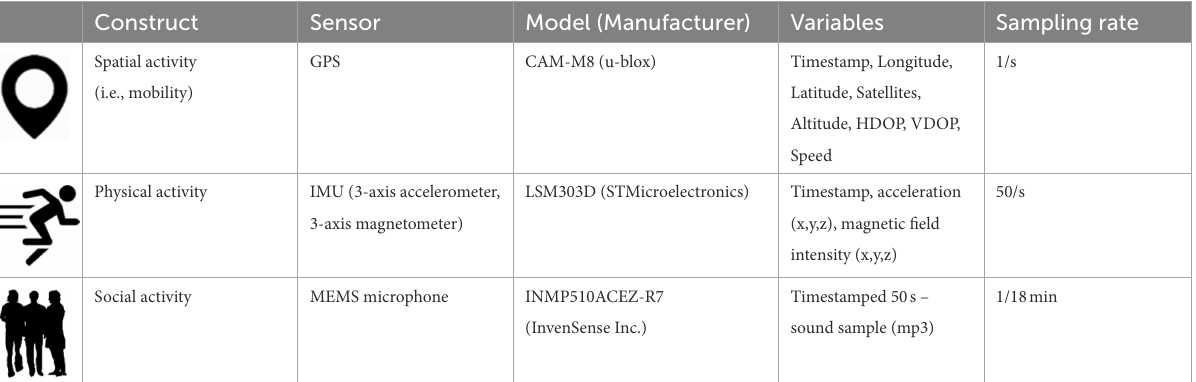
TABLE 3 uTrail mobile sensor device used in the MOASIS